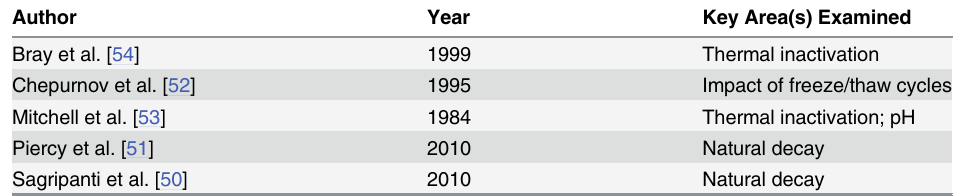
Table 1. Articles examining Ebolavirus environmental survival and sensitivities relevant to